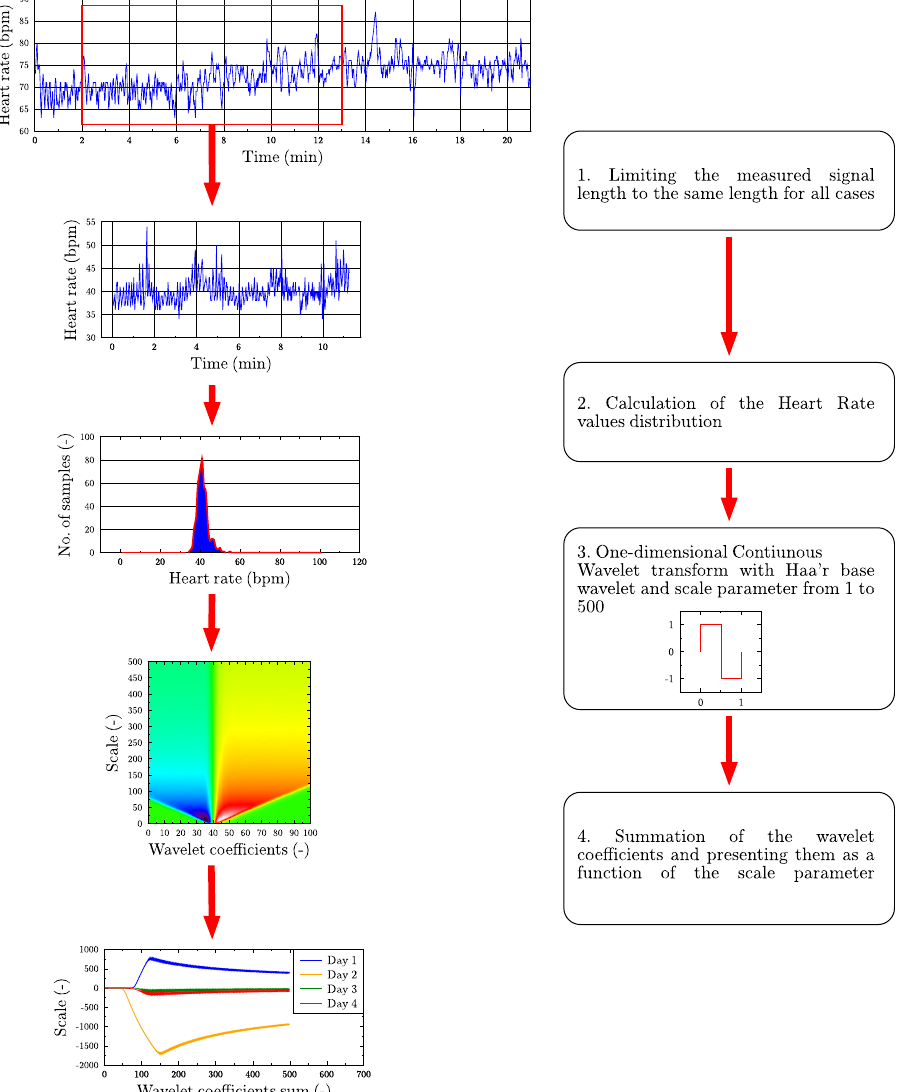
Figure 1. A schematic diagram for the signal analysis methodology based of the application of Continuous Wavelet Transform (CWT), used for calculation of the sums of wavelet